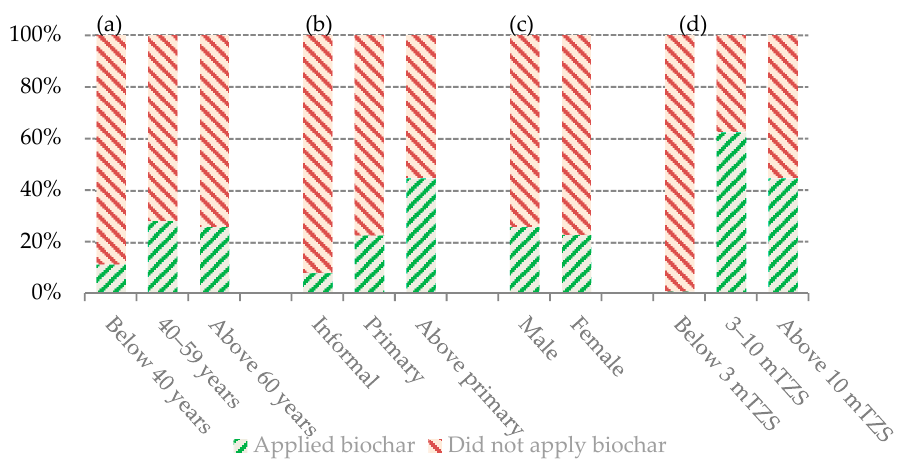
Figure 2. Distribution of level of inclination to produce and apply biochar by: ( a ) respondents belonging to different age categories ( n <40 = 26; n 40–60 = 123; n >60 = 23), ( b ) different level of education ( n informal = 12; n primary = 131; n high = 29), ( c ) gender ( n male = 146; n female = 26), and ( d ) income category ( n <3m = 95; n 3–10m = 48; n >10m = 29).